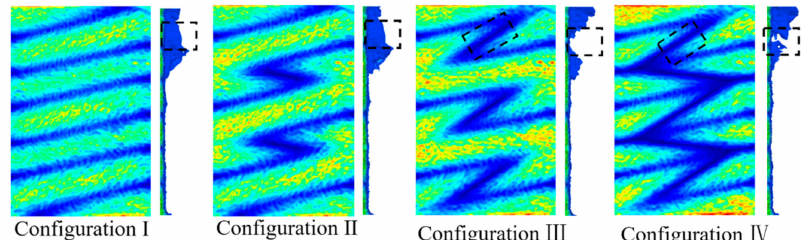
Figure 6. Current density